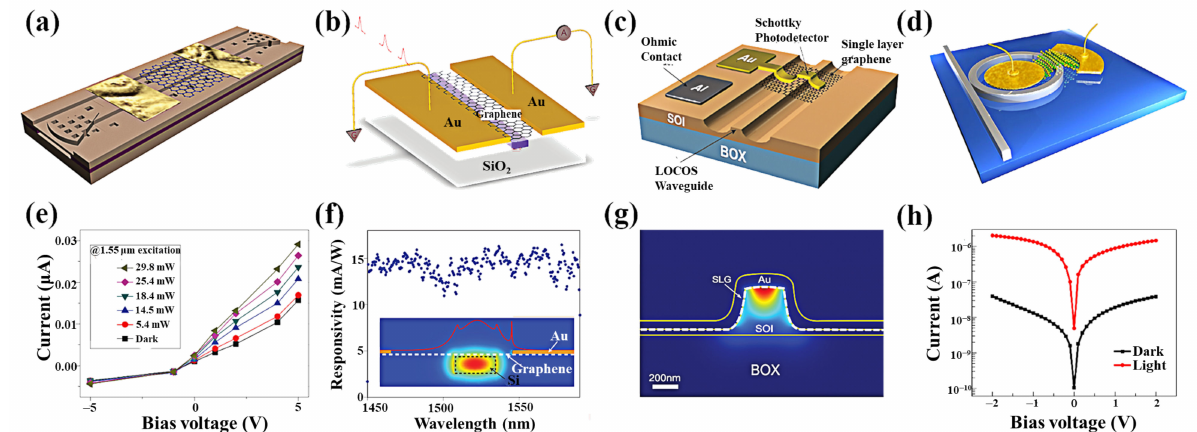
Figure 12. Optical waveguides. ( a ) Schematic of the graphene/silicon-heterostructure waveguide photodetectors. ( b ) Schematic of the device. The silicon bus waveguide fabricated on a silicon-on-insulator wafer is planarized using SiO2. ( c ) Schematic of Si-SLG Schottky photodetectors integrated with photonic waveguides. ( d ) A schematic of an MRR-integrated MoTe 2 photodetector. ( e ) Dark and illuminated current versus bias voltage of the same device as under different incident light powers. ( f ) Broadband uniform responsivity over a wavelength range from 1450 nm to 1590 nm at zero bias. Inset: simulated electric field of the TE waveguide mode. ( g ) Finite element simulated optical intensity profile of an SPP waveguide mode supported by an M-SLG-Si structure. ( h ) Typical I–V characteristics (semi-logarithmic plot) of the Au/MoTe 2 /Au diode showing around two orders of magnitude enhancement for light (red) over dark (black) conditions. ( a , b , d – f , h ) Reproduced with permission from [111,152,153]. Copyright Nature Publishing Group, 2013, 2019. ( c , g ) Reproduced with permission from [154]. Copyright American Chemical Society,